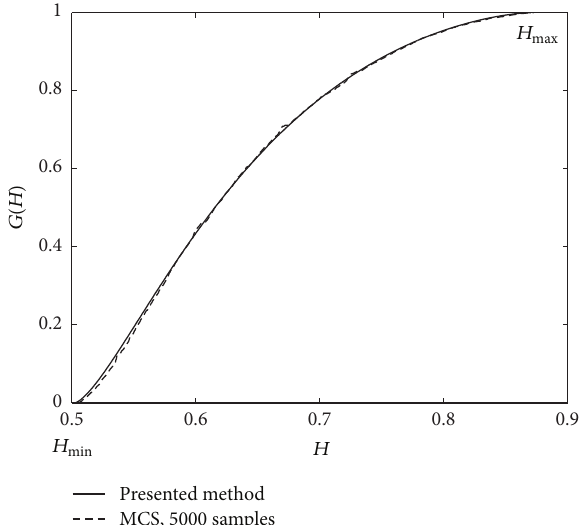
Figure 3: Distribution functions of 𝐻 obtained by the presented method and by MCS, respectively. Parameters are given as 𝑈/𝑈 𝑓 = = 100 , and 𝛿 = 50 . 2 , 𝛿 0 1